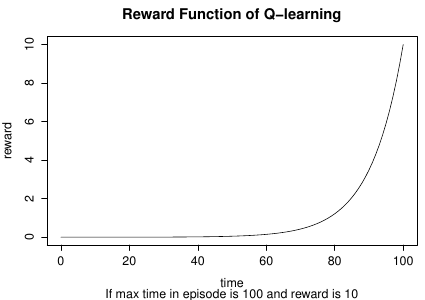
Figure 1: Reward function for Pro(cid:28)t Sharing this paper em- ploys